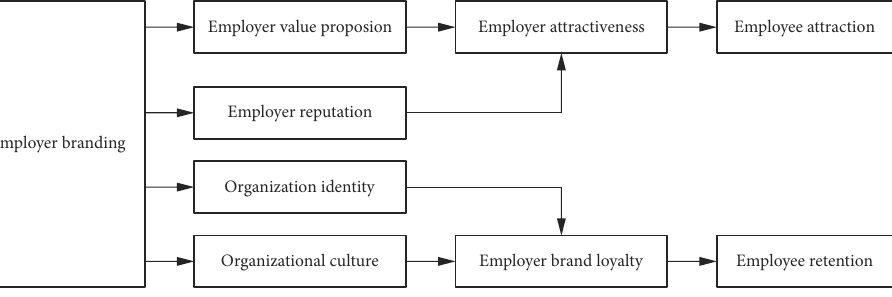
Figure 1. Effect of employer branding on retention and engagement of employees (source: own based on Backhaus & Tikoo, 2004; Berthon et al.,